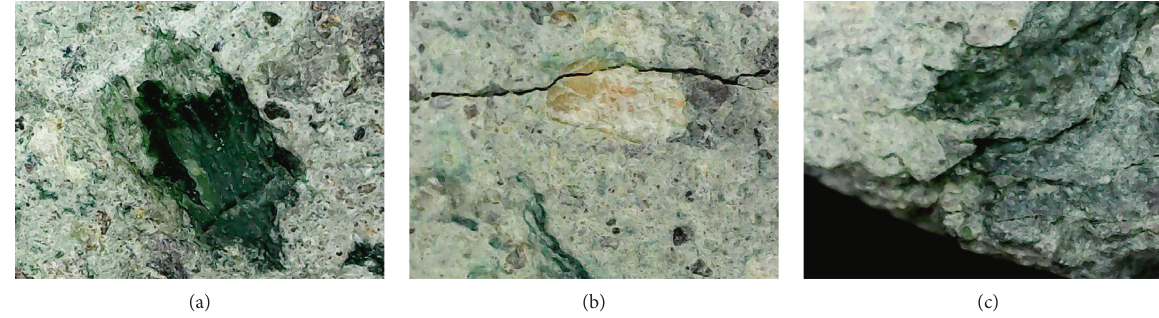
Figure 6: Different degrees of damage were showed in the rock sample surface after 30 F-Tcycles: (a) peeling; (b) cracking; (c) large